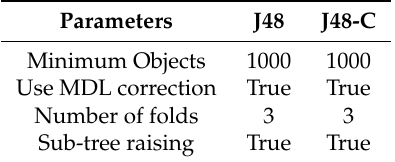
Table 4. J48 and J48-C classifier parameters used in this